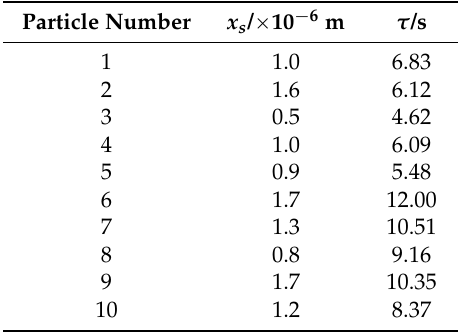
Table 1. x s and τ of 10 particles on growth